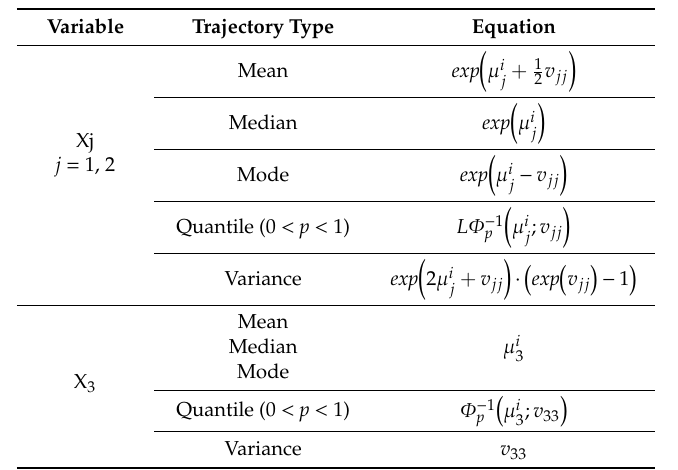
Table 8. Stationary marginal mean, median, mode, p -quantile (0 < p < 1), and variance trends.